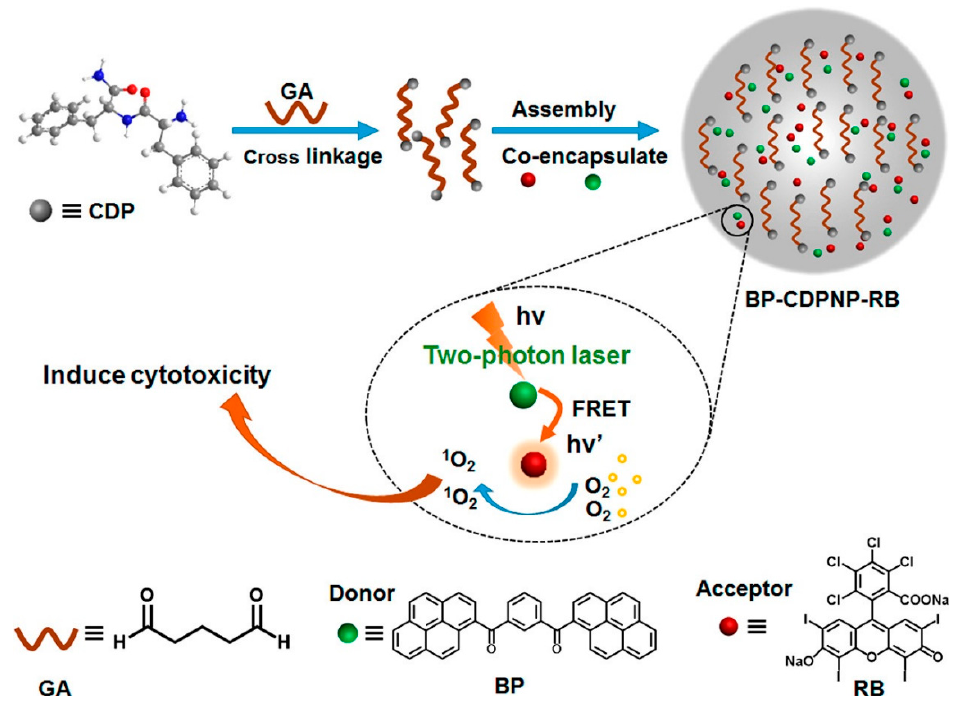
Figure 8. Schematic Illustration of fabrication of BP-CDPNP-RB nanosystem and application of TPA-PDT via intraparticle FRET (Reproduced with the permission from Ref. [75]. Table 1. Photophysical properties and imaging applications of important bis-pyrene com- pounds/systems.